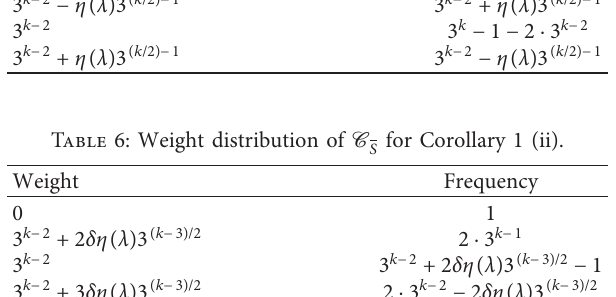
Table 5: Weight distribution of C